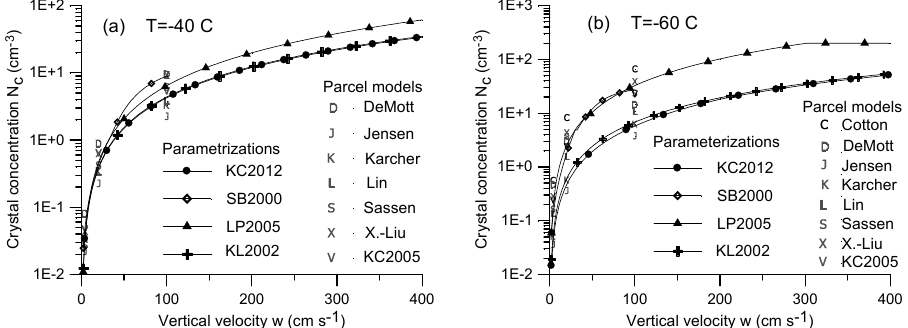
Fig. 9. Comparison of the new parameterization (87), (89) of the crystal concentration N c (w) as a function of w (KC2012) with the pa- rameterizations by Sassen and Benson (2000, SB2000, limited to w = 100cms − 1 ) , Liu and Penner (2005, LP2005), K¨archer and Lohmann (2002, KL02), and with parcel model simulations from Lin et al. (2002) (Cotton, DeMott, Jensen, K¨archer, Lin, Sassen, Liu, as indicated in the legend) and from Khvorostyanov and Curry, 2005 (KC2005) for the three values of w = 4, 20 and 100cms − 1 .